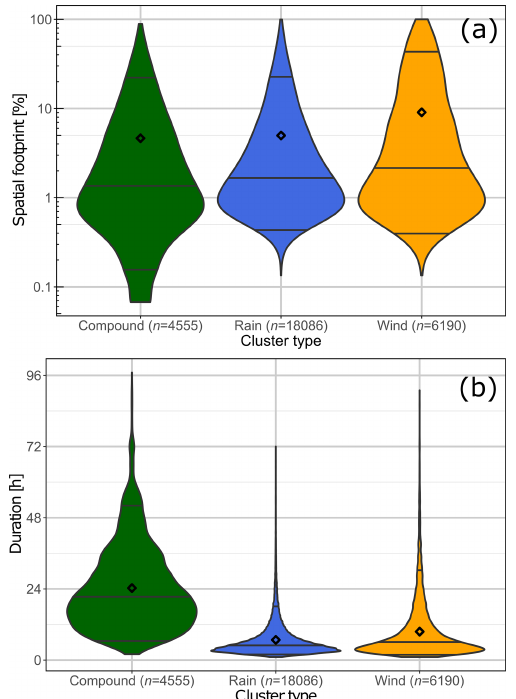
Figure 9. Violin plots for 4555 compound, 18086 precipitation, and 6190 wind clusters for January 1979 to September 2019 from the ERA5 Hazard Clusters Database 1979–2019 (Supplement 3). Shown are (a) the spatial scale as a percentage of the total study area and (b) duration in hours (h). Black diamonds represent the mean of the distributions. Quantiles 0.05, 0.5, and 0.95 are also displayed with horizontal lines. See Fig. 8 for 10 examples of